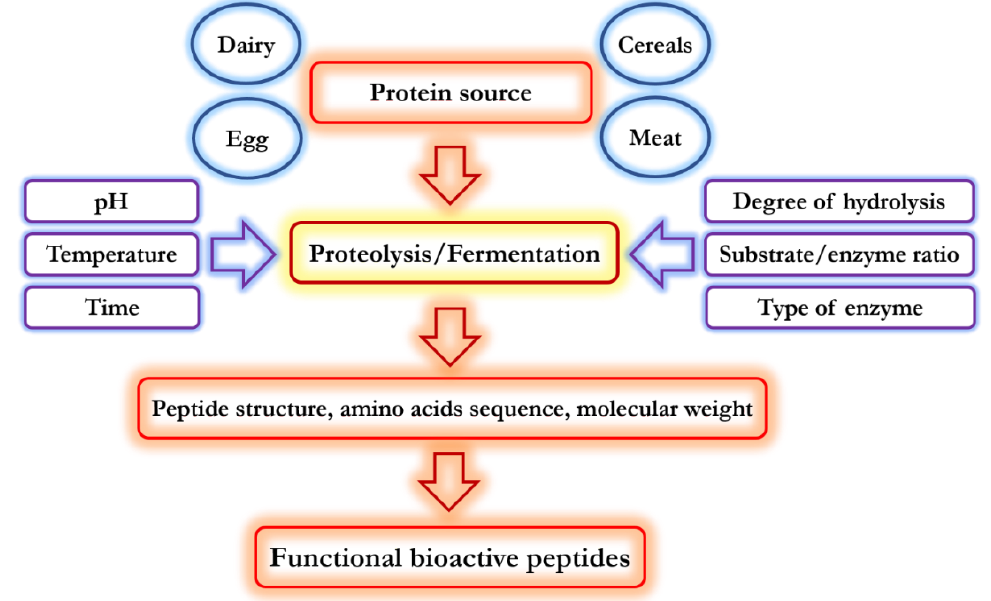
Figure 2. Effect of different operational conditions and parameters on biological and functional properties of bioactive